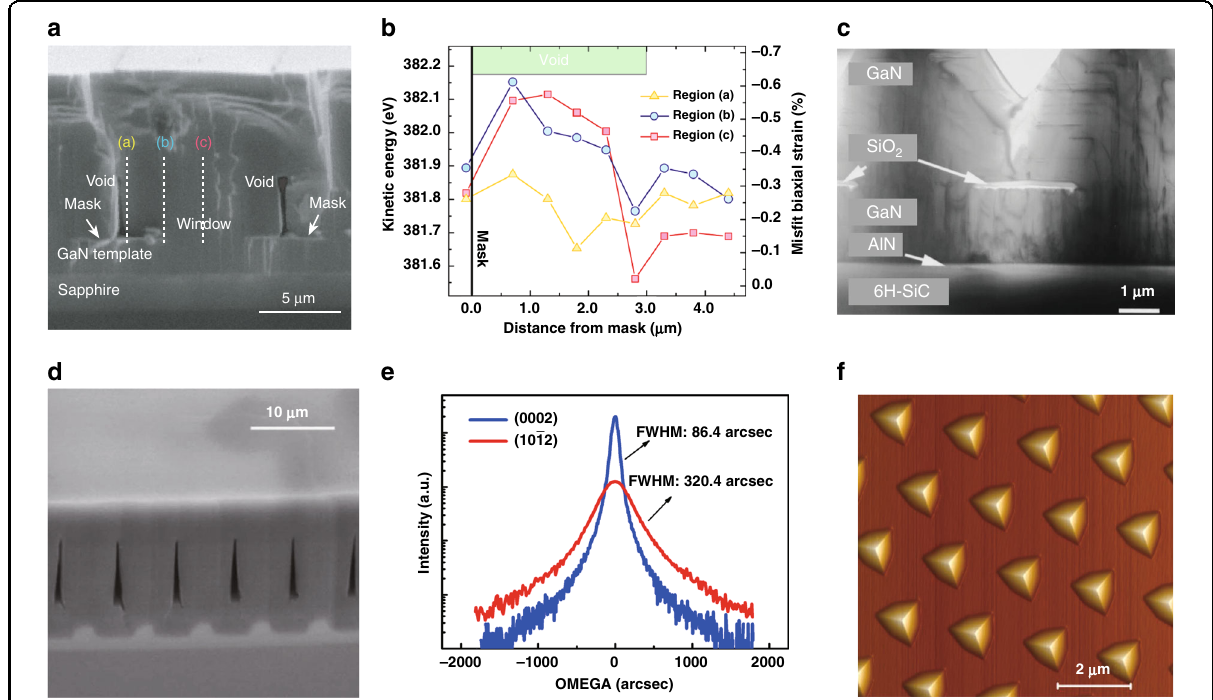
Fig. 5 Strain fi eld relaxation through ELOG method. a SEM image of the cross-section of ELO GaN. b Mis fi t biaxial strain distributions in ELO GaN by AES. c Cross-sectional TEM micrograph in [1120] orientation from a selectively grown GaN stripe revealing the coalescence and change of the direction of dislocation lines. d Cross-sectional SEM micrograph of a fully coalesced 20â €‰ μ m-thick AlN fi lm grown by migration enhanced lateral epitaxial overgrowth technique. e XRCs of (0002) and (1012) diffractions for the AlN fi lms grown on the nanopatterned substrate. f 3D AFM image for the surface morphology of the pyramidal patterned sapphire substrate. Figures reproduced from a and b ref. 81 , © 2005 AIP Publishing; c ref. 78 , © 1997 AIP Publishing; d and e ref. 84 , © 2013 AIP Publishing; f ref. 85 , © 2019 AIP